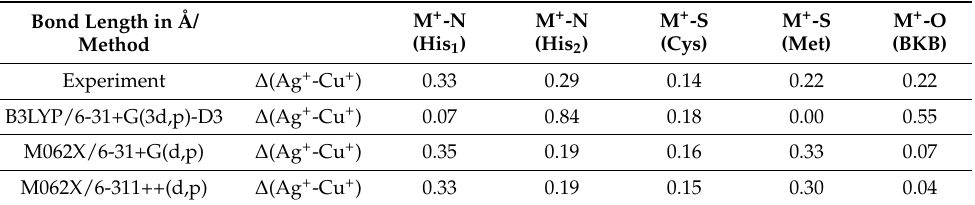
Table 1. Bond lengths used for justification of the chosen computational protocol. The experimen- tal data are taken form the Cu + /Ag + —Azurin structures, corresponding PDB Entries: 1JZG [21] and 3UGE